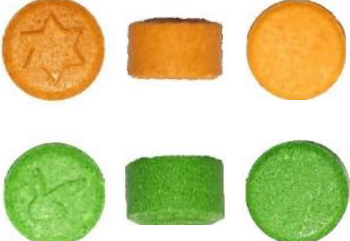
Figure 1. MDMA tablets from street samples provided by Forensic Chemistry Section, General Department of Forensic Science and Criminology, at Dubai Police. Samples from the same seizure revealed physical similarities (diameter of 8.22 mm, measured using a calibrated Mitutoyo Caliper). However, tablets exhibited different logos and colors.